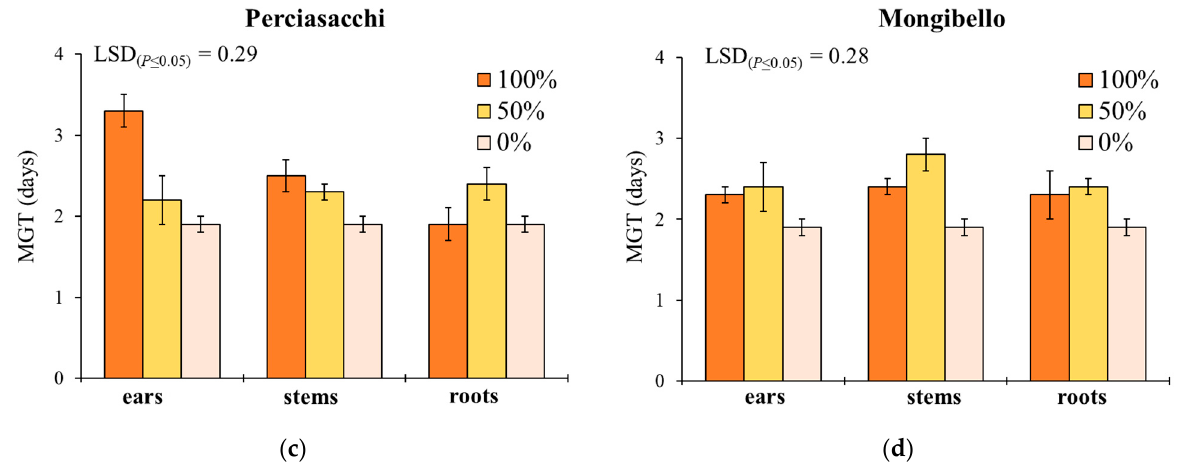
Figure 2. Mean germination time (MGT, days) of Portulaca oleracea as affected by durum wheat gen- otype, plant part and extract dilution. ( a ) ‘Timilia’; ( b ) ‘Russello’; ( c ) ‘Perciasacchi’; ( d ) ‘Mongibello’; Least Significant Difference (LSD) interaction was calculated with the LSD test at p < 0.05. Bars indicate ± standard error.